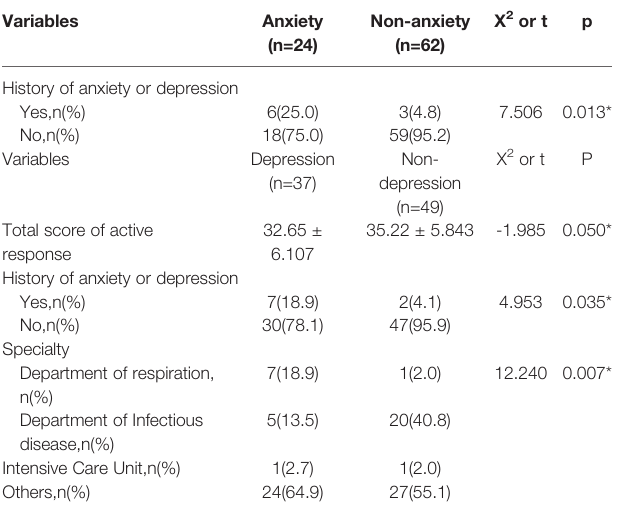
TABLE 4 | Possible in fl uencing factor related to anxiety or depression in nurses.